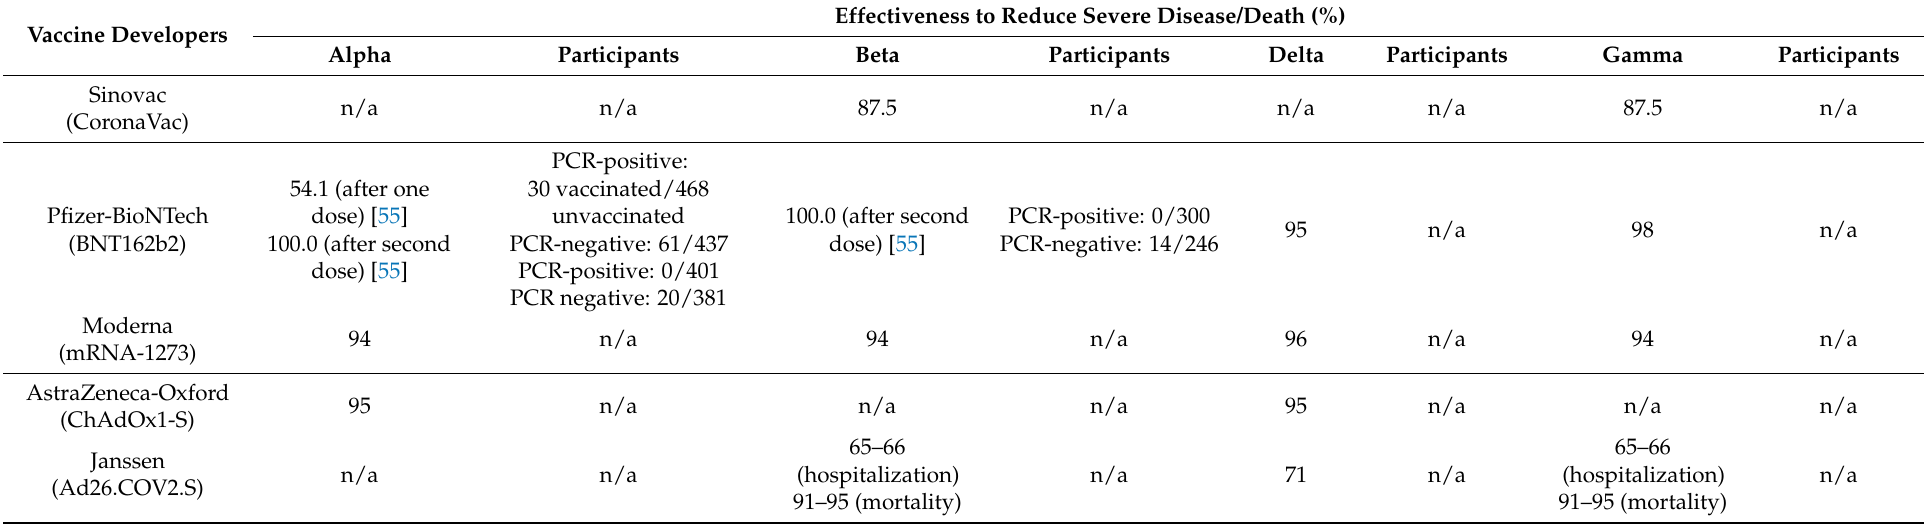
Table 3. Effectiveness of COVID-19 vaccines against severe disease